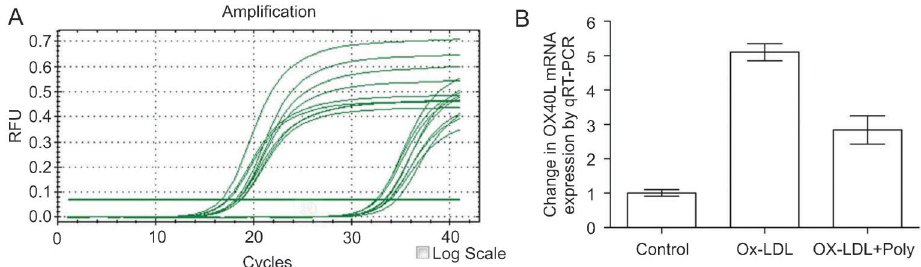
Figure 6. A , Quantification cycles of OX40L mRNA. B , OX40L expression with no Ox-LDL (Control), 100 m g/mL Ox-LDL, and 250 m g/ m L Poly I plus 100 m g/mL Ox-LDL. OX40L mRNA expression in Ox-LDL was increased compared to control while OX40L mRNA expression in Ox-LDL++Poly 1 was decreased compared to Ox-LDL (n=4; *P , 0.05, t -test). Ox-LDL: oxidative low-density lipoprotein; Poly I: polyinosinic acid.